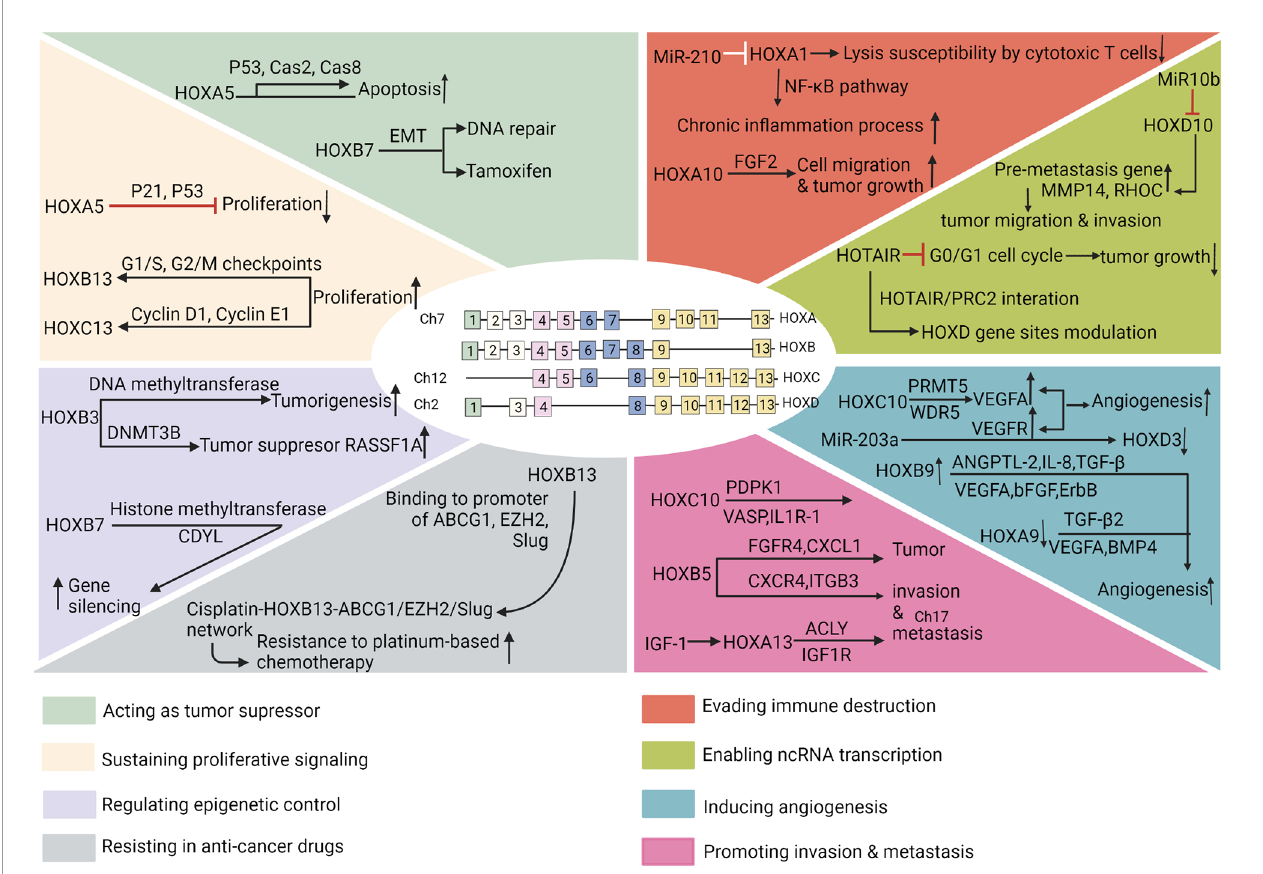
FIGURE 2 | HOX genes in the hallmarks of cancer. The hallmarks of cancer comprise eight biological capabilities acquired during multistep development of human tumors. The hallmarks constitute an organizing principle for rationalizing the complexities of neoplastic disease. They include acting as tumor suppressor, sustaining proliferative signaling, regulating epigenetic control, resisting in anti-cancer drugs, evading immune destruction, enabling ncRNA transcription, inducing angiogenesis, and promoting invasion and